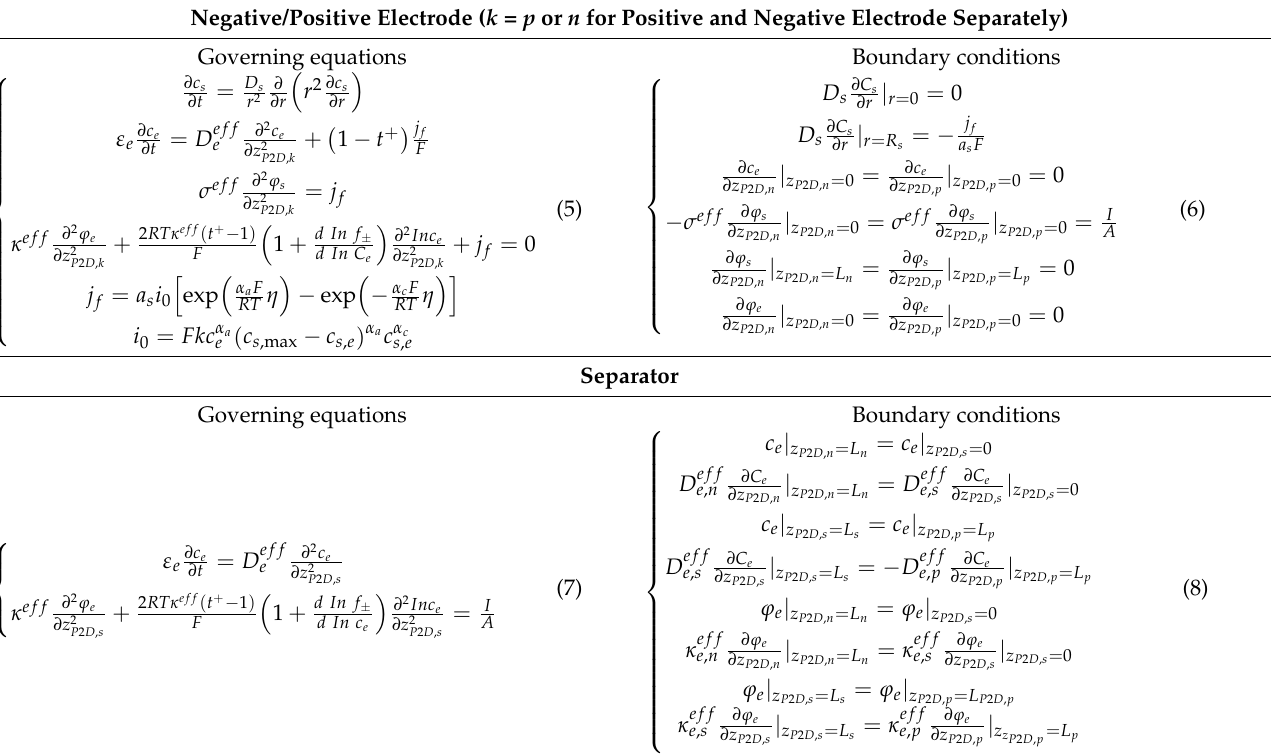
Table 2. Structure of P2D model in the z P 2 D coordinate. Negative/Positive Electrode ( k = p or n for Positive and Negative Electrode Separately) Governing equations Boundary conditions